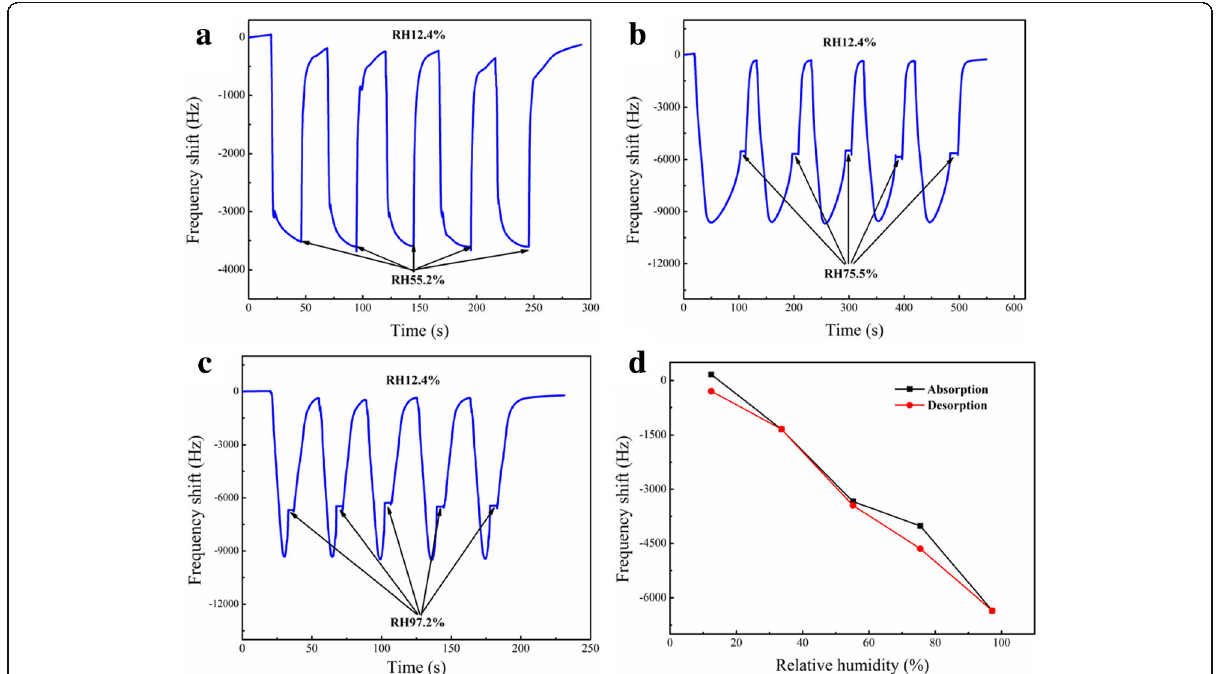
Fig. 4 The repeatability characteristic curves of QCM-based PA66/CoCl 2 ·6H 2 O (50 wt%) NFM sensor for 5 cycles of RH adsorption – desorption a between 12.4 and 55.2% RH, b between 12.4 and 75.5% RH, and c between 12.4 and 97.2% RH. d Humidity hysteresis characteristic of QCM- based PA66/CoCl 2 ·6H 2 O (50 wt%) NFM